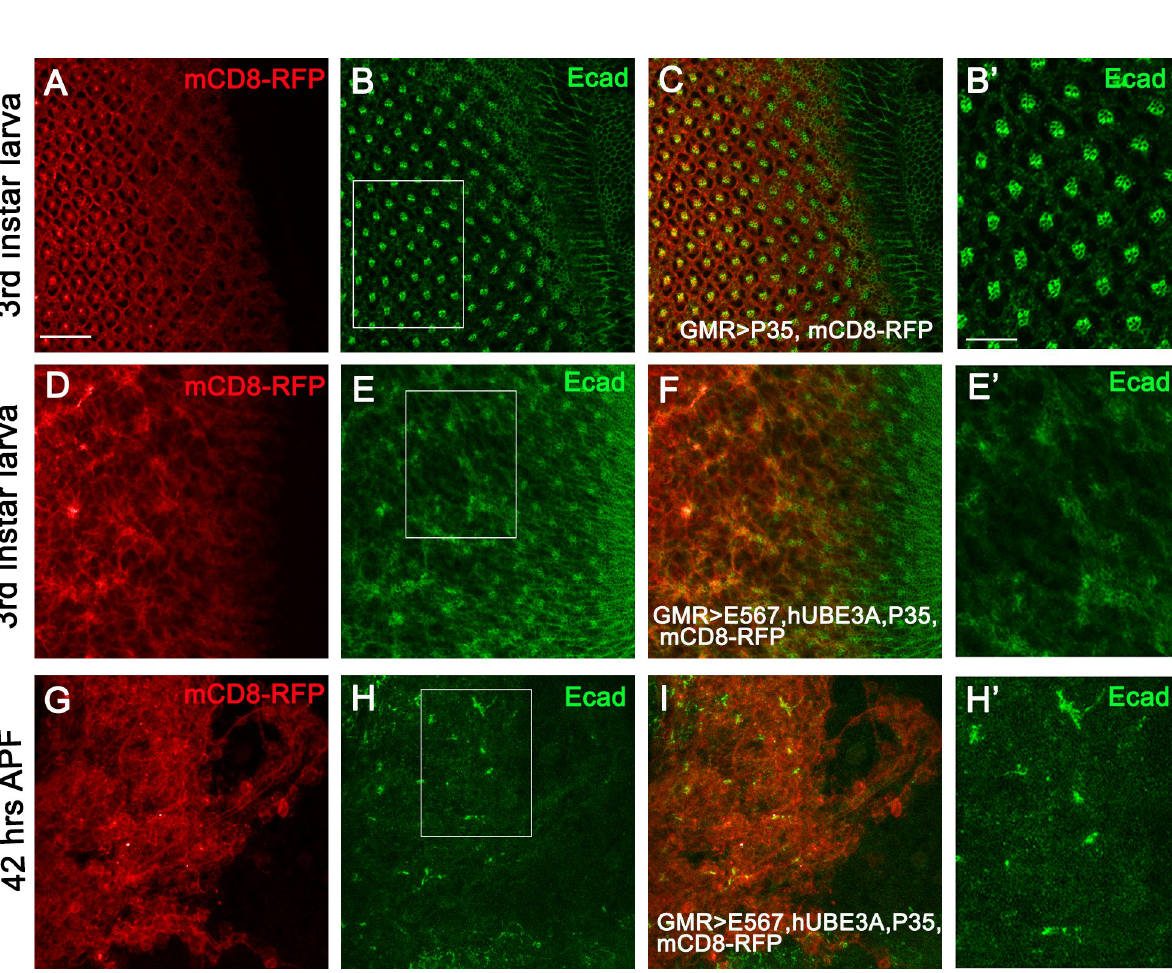
Fig 4. HPV16 E5, E6, E7+hUBE3A-induced loss of adherens junctions and impaired cell differentiation is independent of programmed cell death. Transgenes were expressed in the third instar larval eye discs (A-E’) and in pupal eyes 42 hours after pupation (G-H’) , using GMR-Gal4. mCD8RFP was used to mark the area of transgenes expression and tissues were immunolabeled for adherens junctions protein, E-cad. (A-B’) Eye disc co-expressing mCD8RFP and p35 showed an intact eye epithelium with proper sequential pattern of differentiated ommatidia (B) and adherens junctions (B’) . (D-E’) Eye disc co-expressing HPV16 E5, E6, E7+hUBE3A+ mCD8RFP +p35 exhibited loss of adherens junction protein (E and E’) and impaired ommatidial differentiation (D) despite p35-mediated absence of cell death. (G-H’) Pupal eye 42 hrs after pupation co-expressing HPV16 E5, E6, E7+hUBE3A+ mCD8RFP +p35 showed cluster of cells in which many cells lost adherens junctions whilst some remained attached to each other expressing the E-cad (H, H’) . Insets are digitally magnified 200%. Scale bars in A and B’ represent 100 μ m and 50 μ m, respectively.